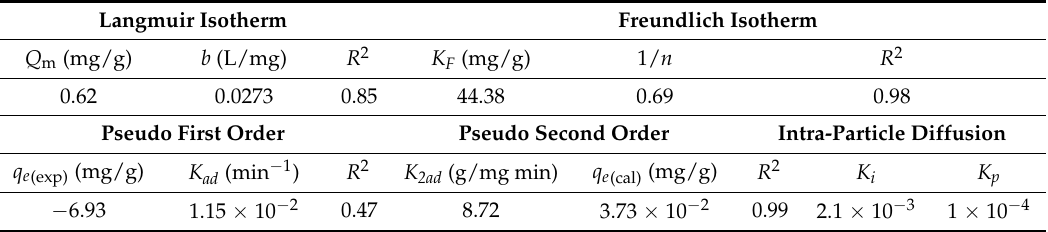
Figure 11. Intra-particle diffusion model of fluoride adsorption on the activated clay. Table 6. Constant values for adsorption isotherms and adsorption kinetics